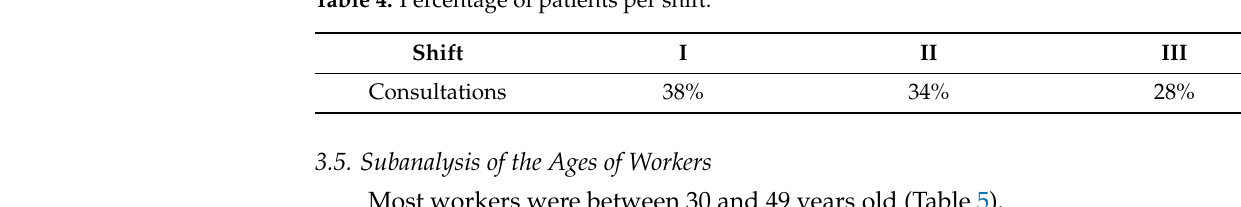
Table 4. Percentage of patients per